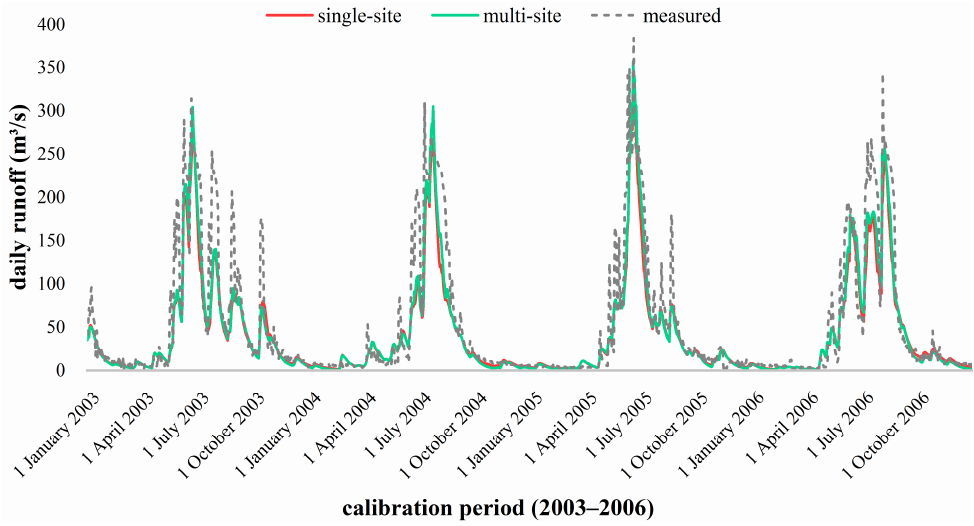
Figure 8. Daily simulated runoff during the calibration period.